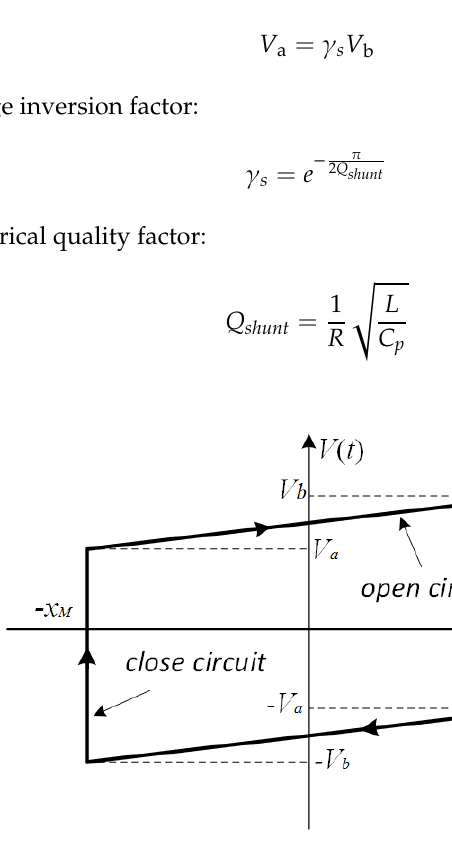
Figure 2. Illustration of the voltage-displacement hysteresis loop of SSDI.